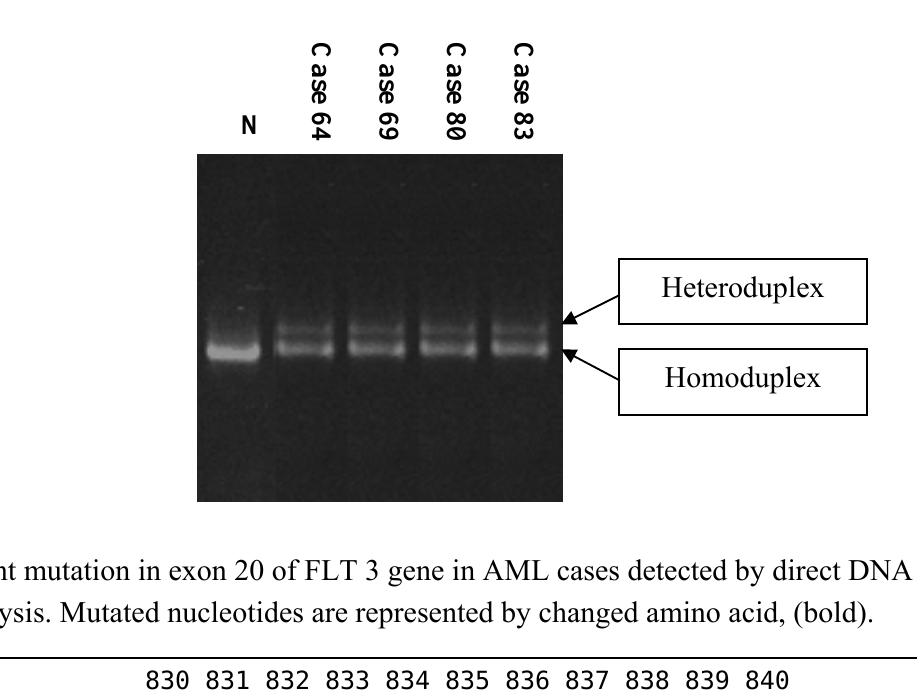
*Small letters indicate nucleotides sequences and capital letters indicate amino acids sequences. *In-frame insertion mutations indicated by bold letter. Figure 3. CSGE analysis of exon 20 of FLT3 gene demonstrating abnormal CSGE pattern compared to that seen in a normal individual (Lane N).